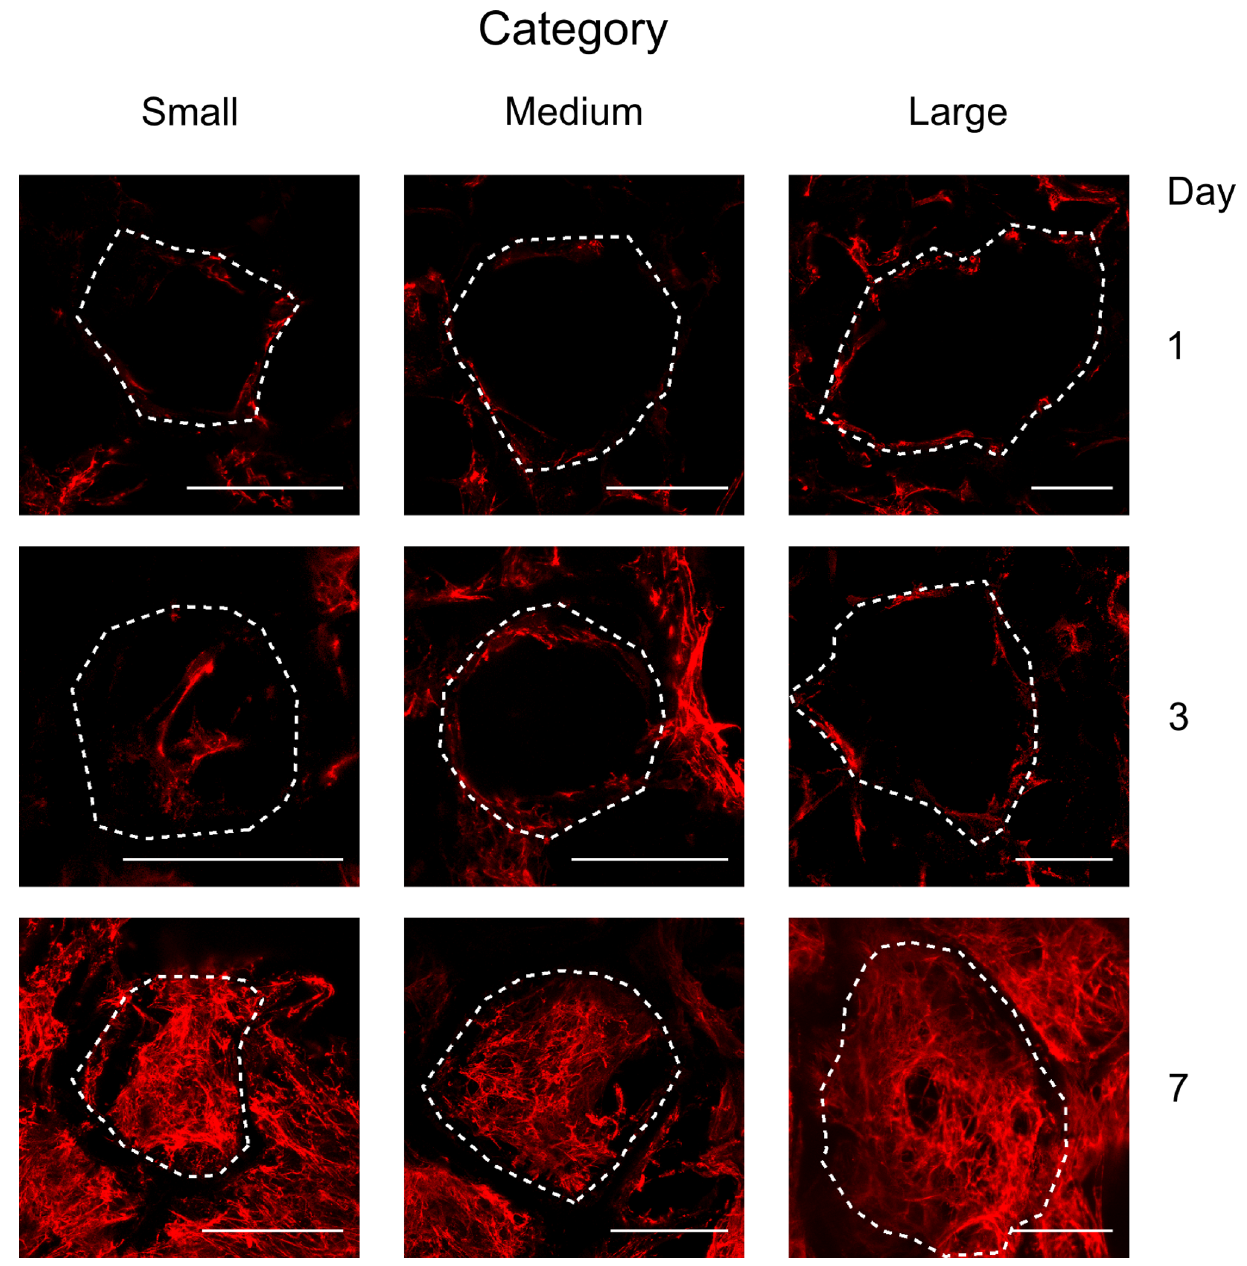
Figure 5. Fibronectin organization for three pore size categories and three time points. Confocal microscopy for visualization of fibronectin network (red) to illustrate the filling of scaffold pores until day 1, 3, and 7 and the three pore size categories (scale bar equals 100 m m). Data shown corresponds to the maximum projection images of the 3D image stacks recorded inside scaffolds. During the imaging, scaffold pores were observed due to some background staining and where delimited here by dashed